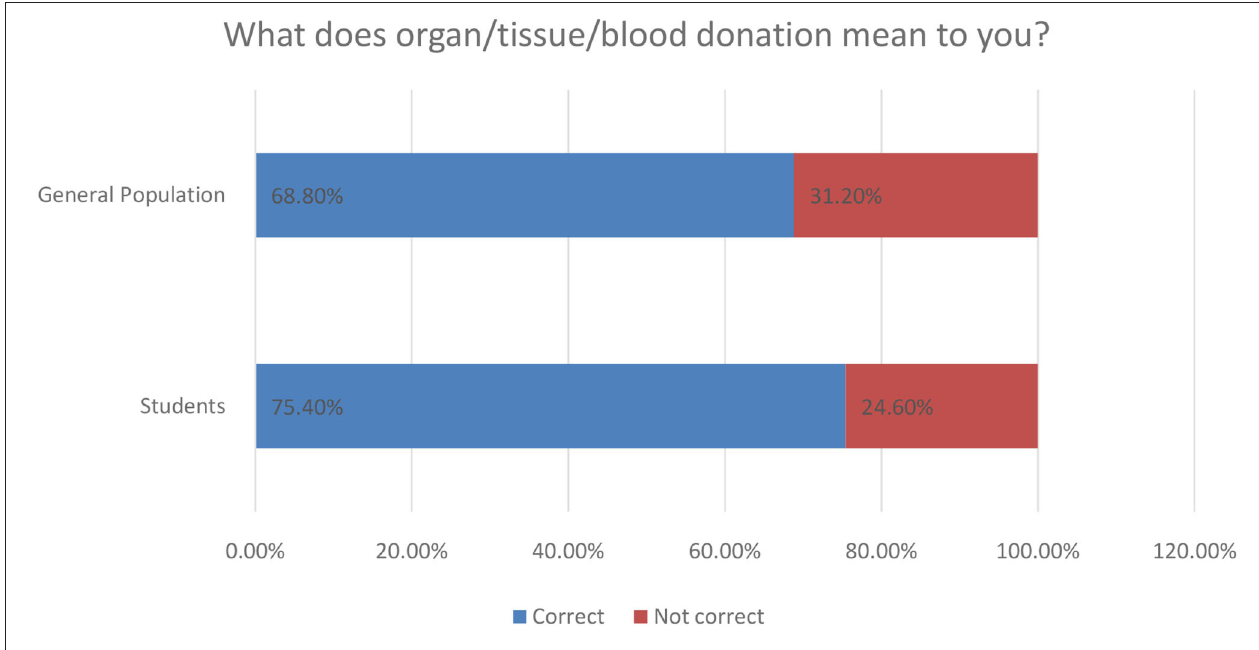
FIGURE 5 | Personal interpretation of kidney donation for respondents.